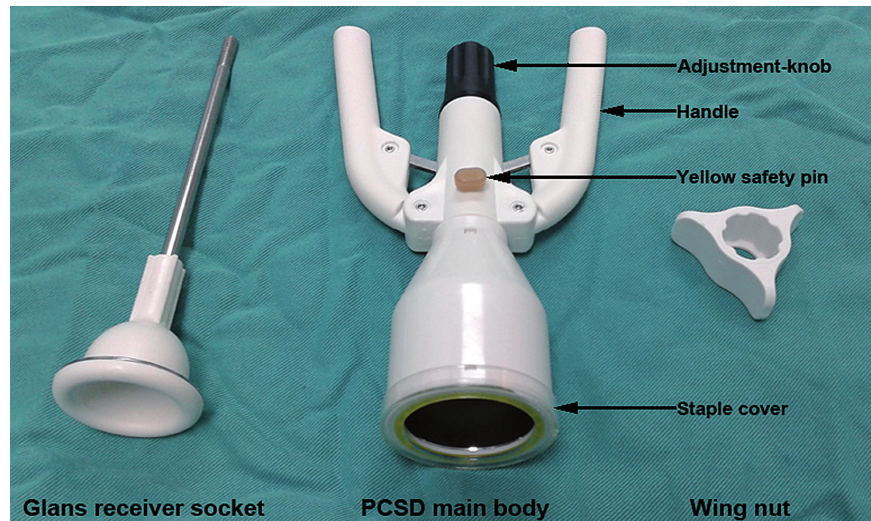
figure 2 - novel penile circumcision and suturing